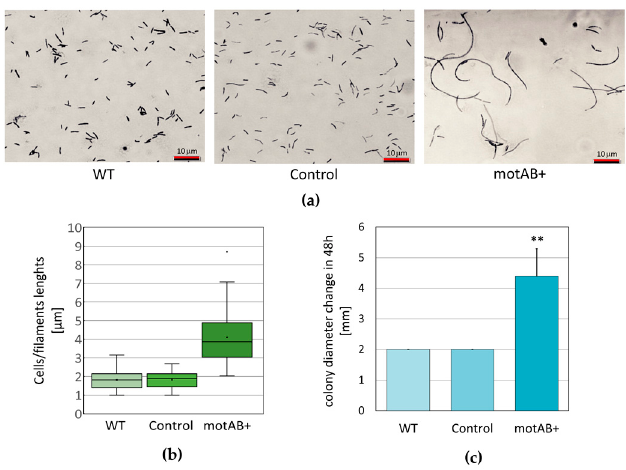
Figure 1. Phenotypes of K. hansenii ATCC 23769 strain variants (WT = wild-type K. hansenii ATCC 23769 strain, Ctrl = strain transformed with pTI99A core vector; motAB+ = mutant transformed with pTI99-motAB vector). ( a ) Bacterial cells/filaments length estimation—representative microphotographs from light microscope Olympus BX 51 of fixed bacterial cells/filaments, stained with crystal violet; ( b ) Bacterial cells/filaments length estimation—box plot showing distributions of 120 measurements of bacterial cells/filaments lengths for each strain; ( c ) Colony spreading assay (swarming motility on soft agar) differences in colonies’ diameters from fifth and third day of incubation in mm are shown. Mean values were calculated from five biological replicates, error bars represent standard deviations, statistical significance was estimated with t -test; ** denotes p <